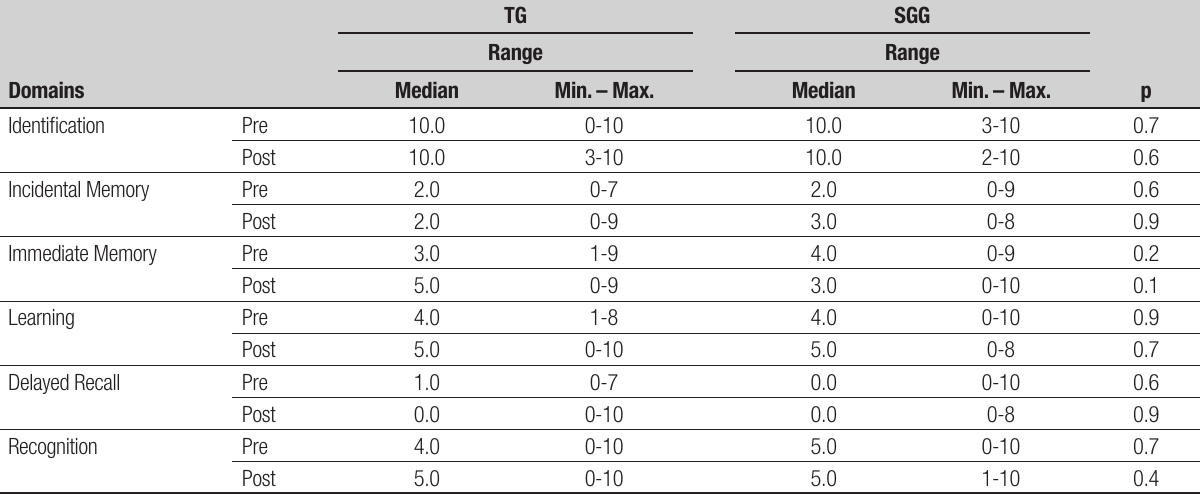
Table 2. Medians, range and p-value of domains on BCB for Training Group (TG) and Social Gathering Group (SGG) pre and post intervention. TG SGG Domains Median Min. – Max. Min. – Max.